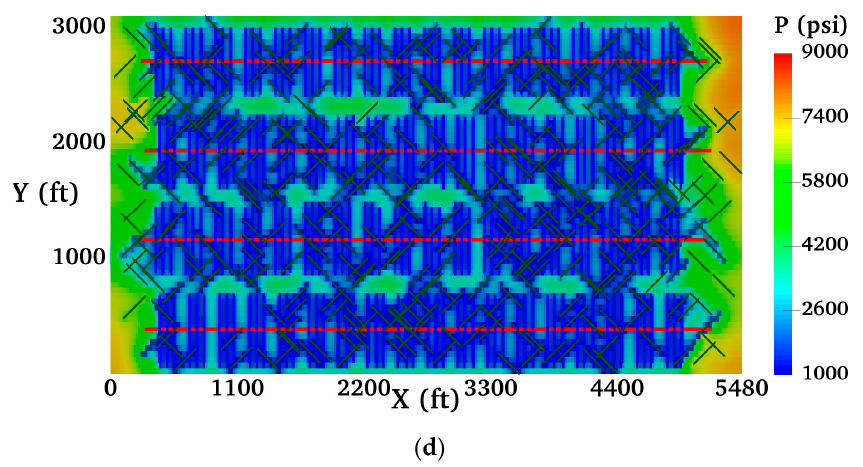
Figure 11. Pressure distributions in the matrix for the optimal well spacing scenario: ( a ) after 1 year; ( b ) after 5 years; ( c ) after 10 years; and ( d ) after 20 years.